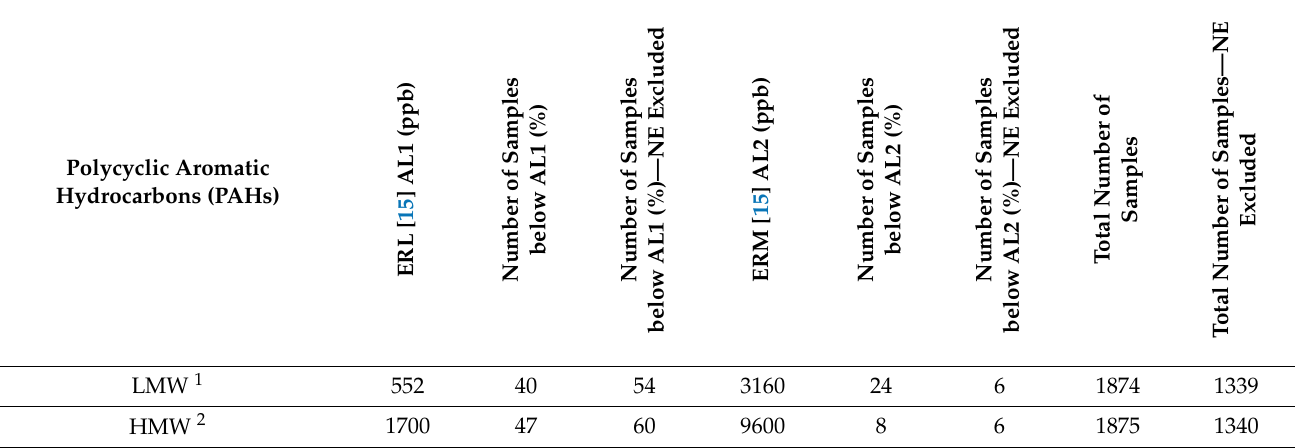
Table 12. Polycyclic Aromatic Hydrocarbons (PAHs)—Summed PAHs—LMW and HMW—ERL and ERMs [15]. Percentage of samples below AL1(ERL) and above AL2 (ERM) and the respective percent- age of samples with Northumbria and Humber samples excluded (NE excluded) are